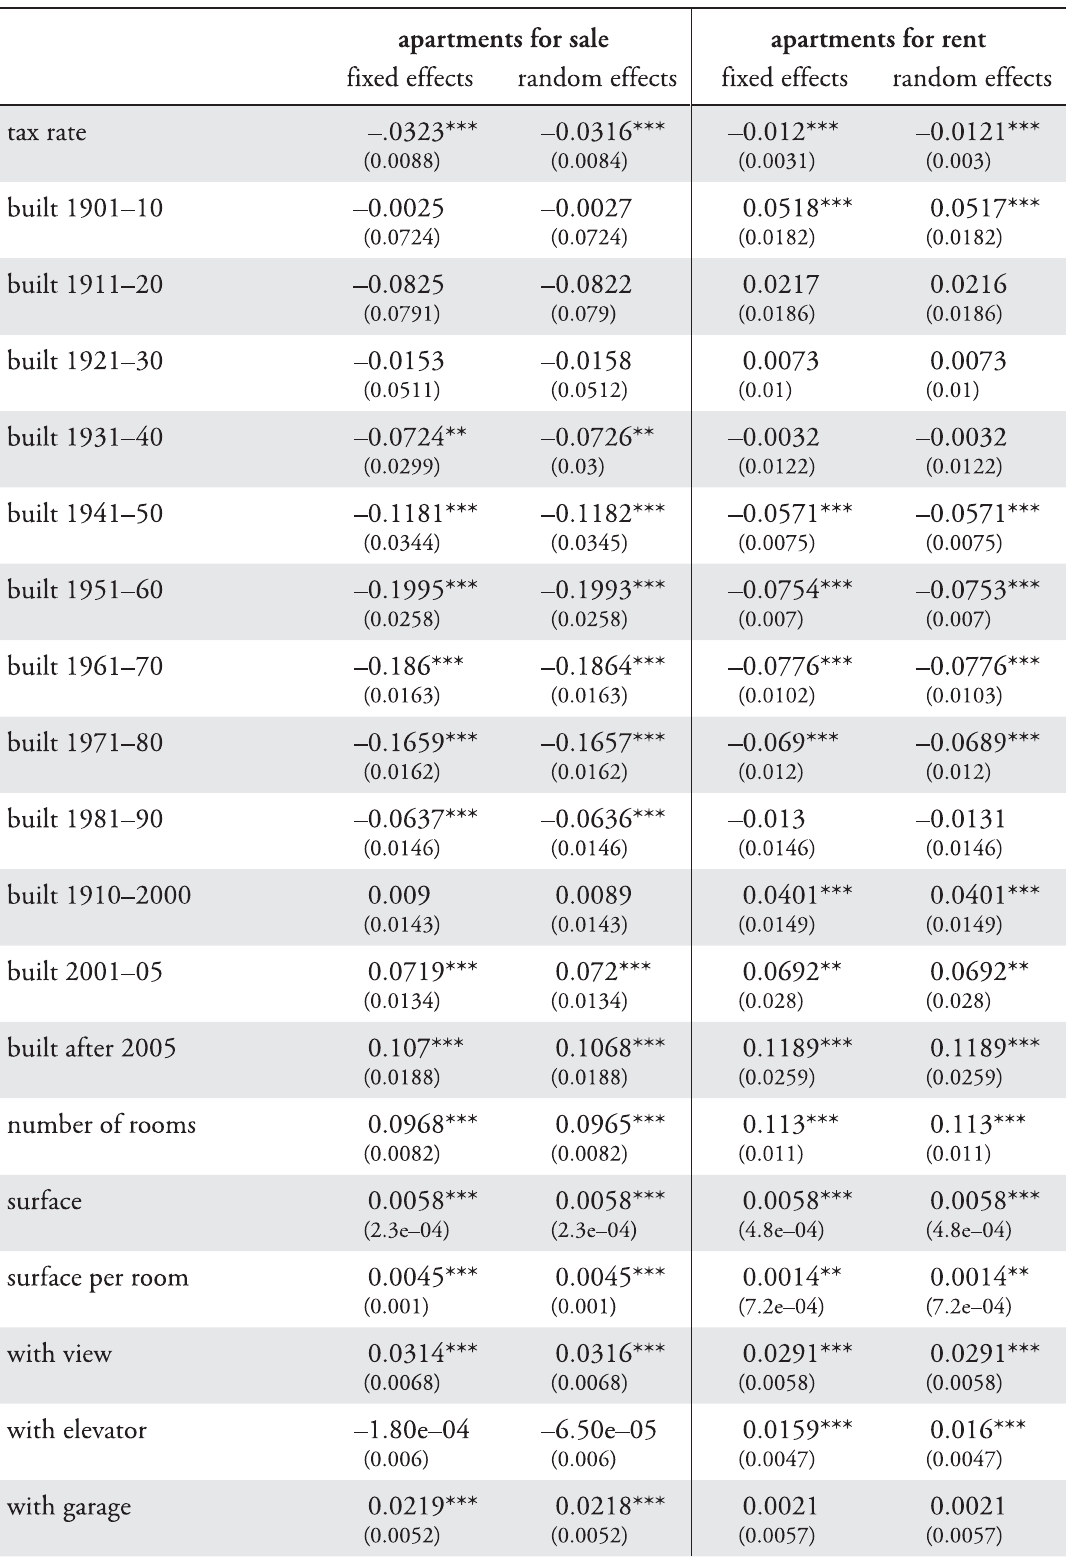
Table 2: Baseline Regression